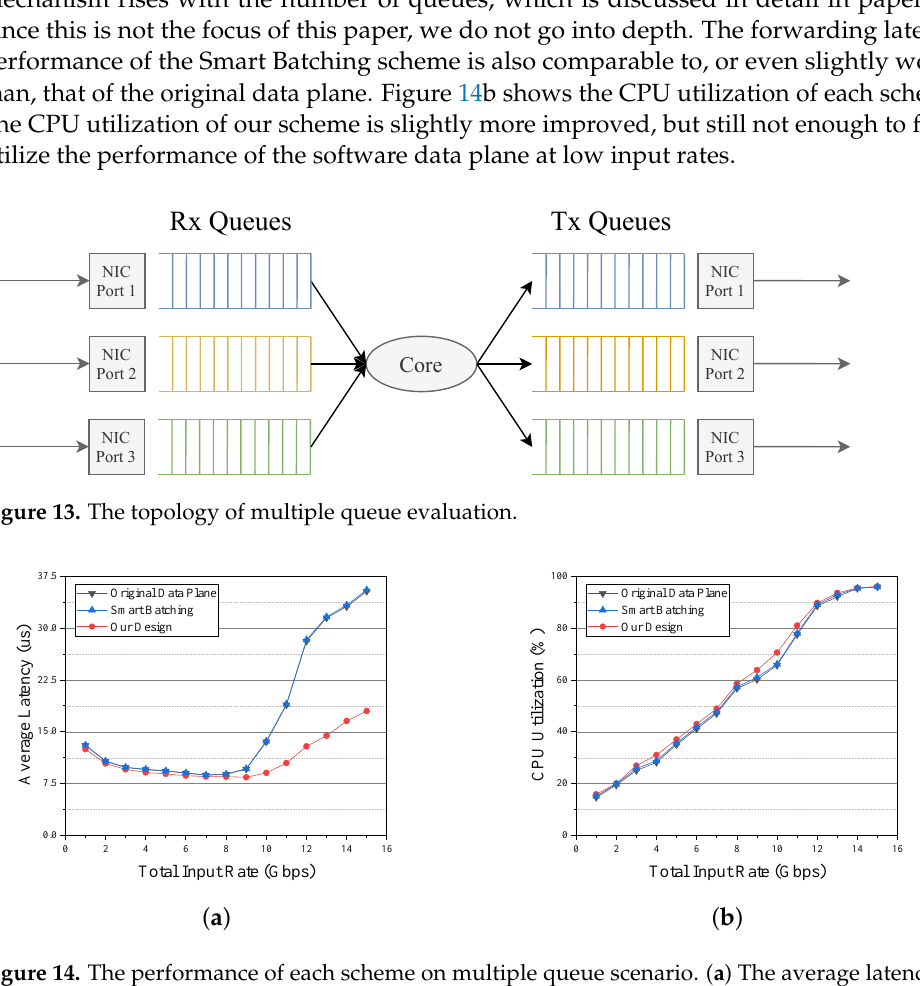
Figure 14. The performance of each scheme on multiple queue scenario. ( a ) The average latency of each scheme under different input rates. ( b ) The CPU utilization of each scheme under different input